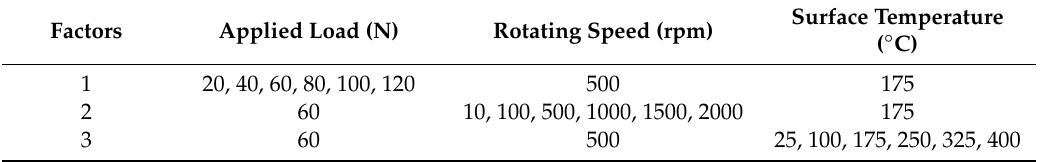
Table 2. Thermophysical properties of the pin and disc.